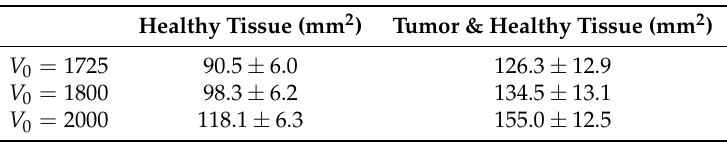
Table 4. Ablation sizes for IRE threshold at >700